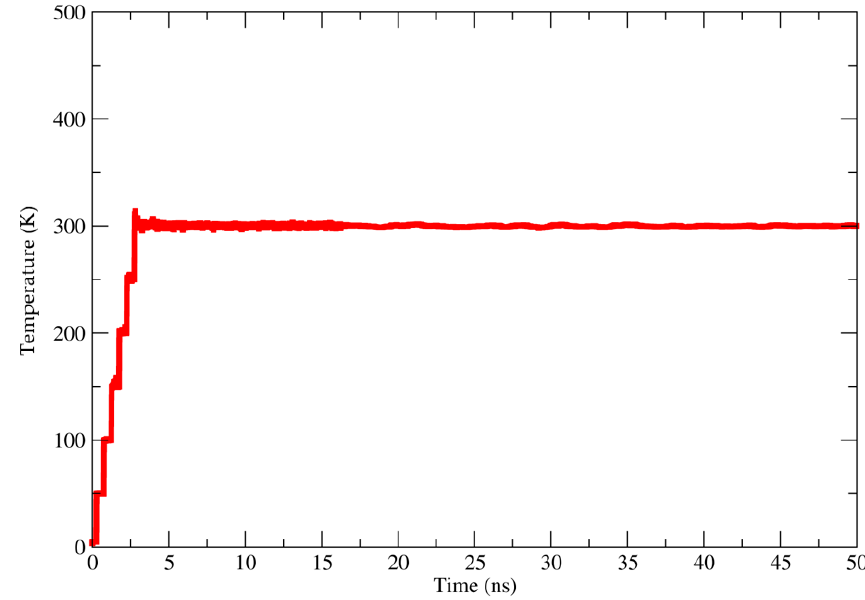
Figure 4. Complex temperature over the MD simulation.